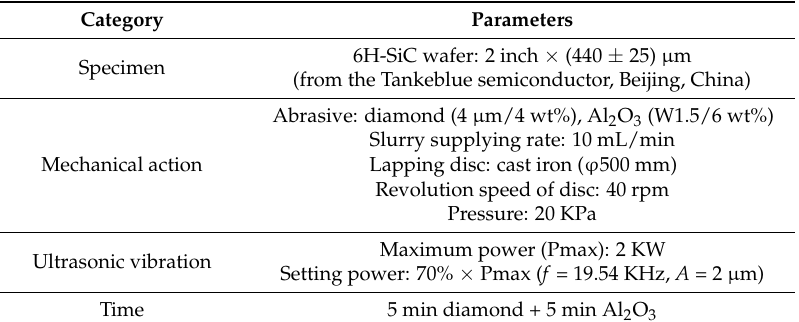
Table 2. Experimental conditions for lapping.